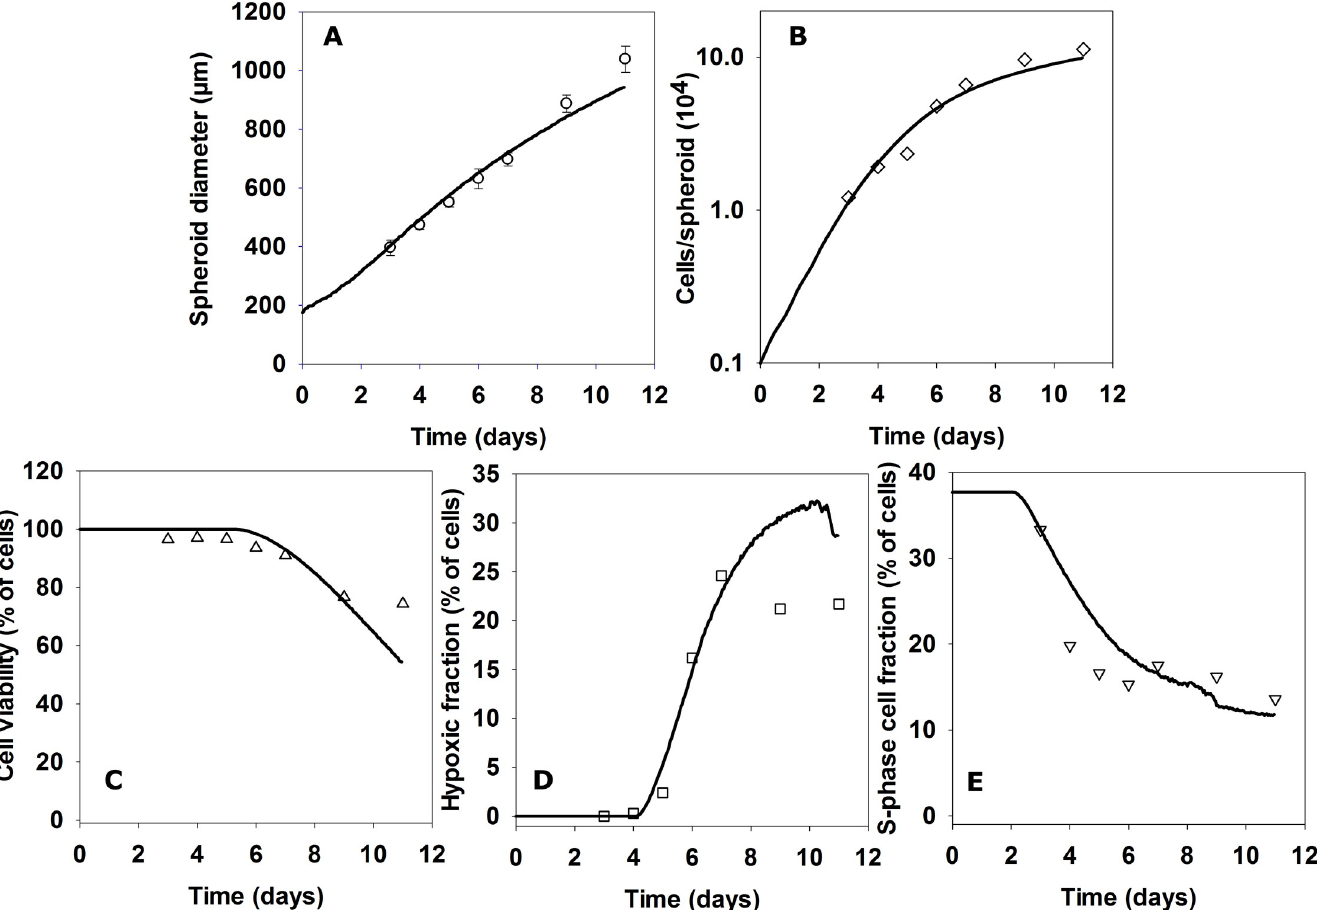
Fig 5. Comparison of growth and cellular characteristics of HCT116 spheroids with outputs of the SABM. On the indicated days, diameters of spheroids ( A ) were measured. Values are means ± SD (n � 48 spheroids). After exposing spheroids to EdU or EF5, spheroids (n = 48 spheroids) were pooled and dissociated and the number of cells in cell suspension were counted to estimate total cell number per spheroid ( B ), followed by exposing cells in 1 μ g/mL PI for 2 min to measure cell viability by flow cytometry (% PI negative, C ). Hypoxic fraction (% EF5-positive cells, D ) and S-phase fraction (% EdU-positive cells, E ) were measured by flow cytometry. The predictions of the SABM (lines), using fitted parameters from monolayer and MCL experiments, plotted with experimental data (points) are: (A) spheroid diameter (A) total cell number, (B), fractions of cells not tagged for death (C), fraction of cells below 0.5 μ M O 2 (D) and estimated S-phase fraction based on the assumption that 37% of cells were initially in